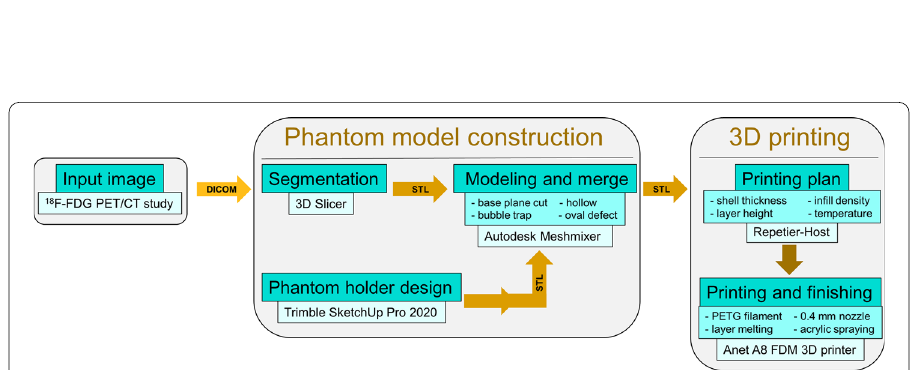
Fig. 4 Flowchart of steps required to create the LVm phantom models. Input data were an 18 F-FDG PET/ CT study of a patient without known coronary artery disease. Three different software were used for model construction, and an additional program was applied to create the printing plan at different stages of the manufacturing process. Finished models were printed with an Anet A8 FDM 3D